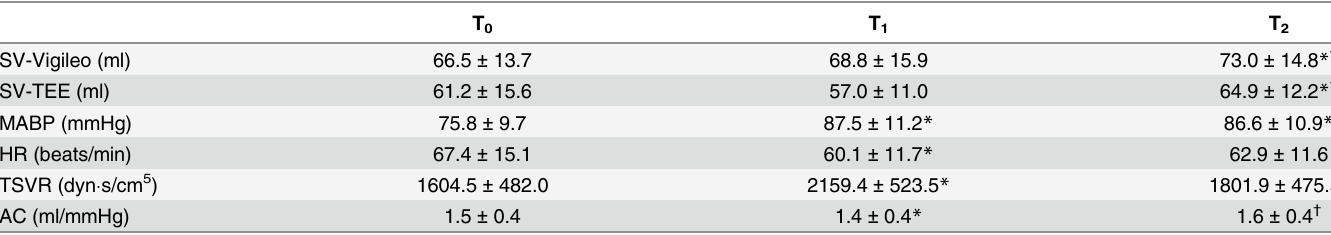
Table 2. Hemodynamic data at different time points.